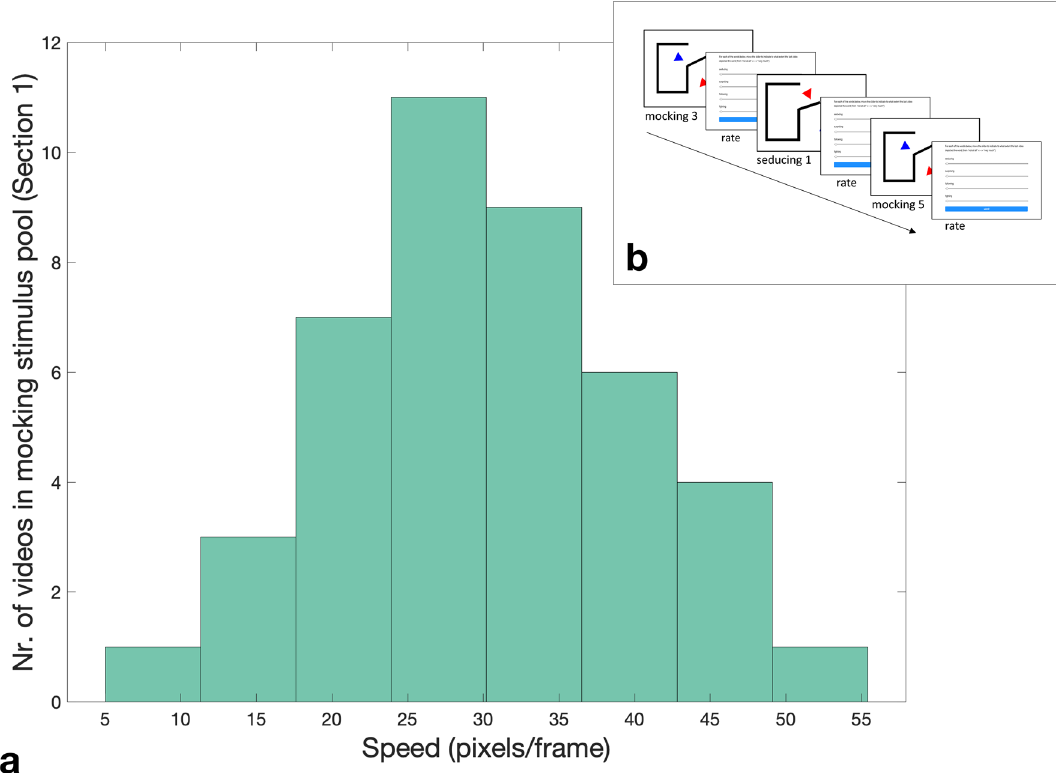
Figure 5. Example of stimulus selection method. ( a ) Example of the stimulus selection method for the word mocking. The selection method was the same for all five word categories. From each of eight percentile bins of the speed frequency distribution for a word category, one animation was selected at random and replayed to the participant. ( b ) Schematic depiction of 3 successive trials in the perception task. Numbers next to words represent the order number of the percentile bin from which the stimulus was selected (e.g., mocking 3 represents a mocking animation from the 3rd bin, which includes animations between the 25th and 37.5th percentile of the speed frequency distribution). Animations presented were selected at random; each animation was followed by a separate screen with five visual analogue sliding scales (one for each of the five word categories), ranging from 1 to